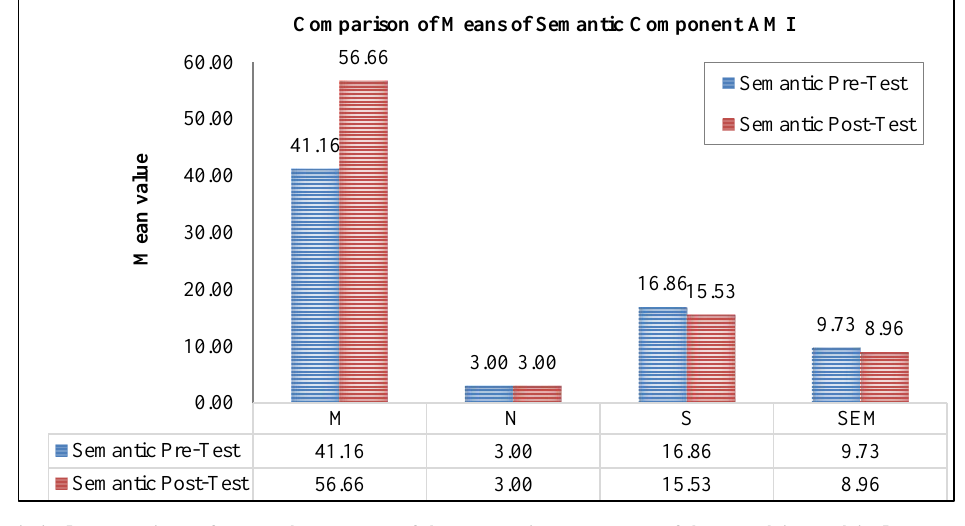
Figure 2. Statistical comparison of pre-and post-tests of the semantic component of the Autobiographical Memory Interview. As seen in Table 4, the post-test exceeded the value of = -15.50, achieving a significant difference between variables, which contributes empirical evidence in favor of the hypothesis. Table 4. Paired sample test.